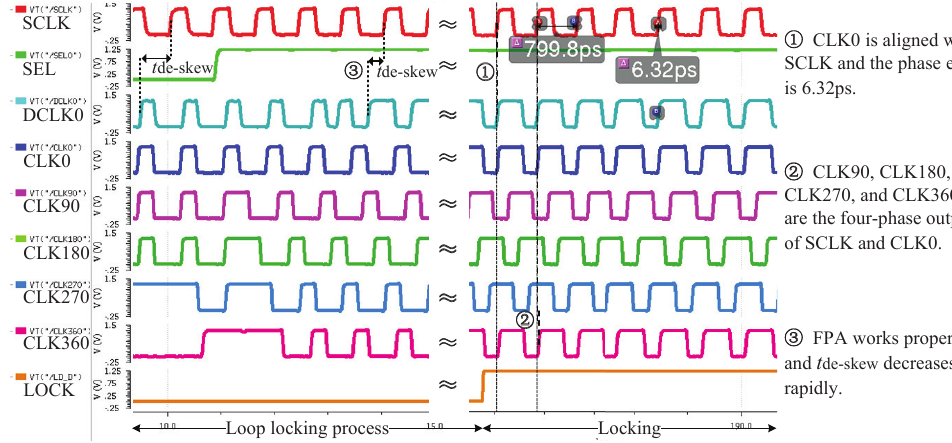
Figure 16. The locking process of four-phase DLL with de-skew circuit at f clock = 1.25